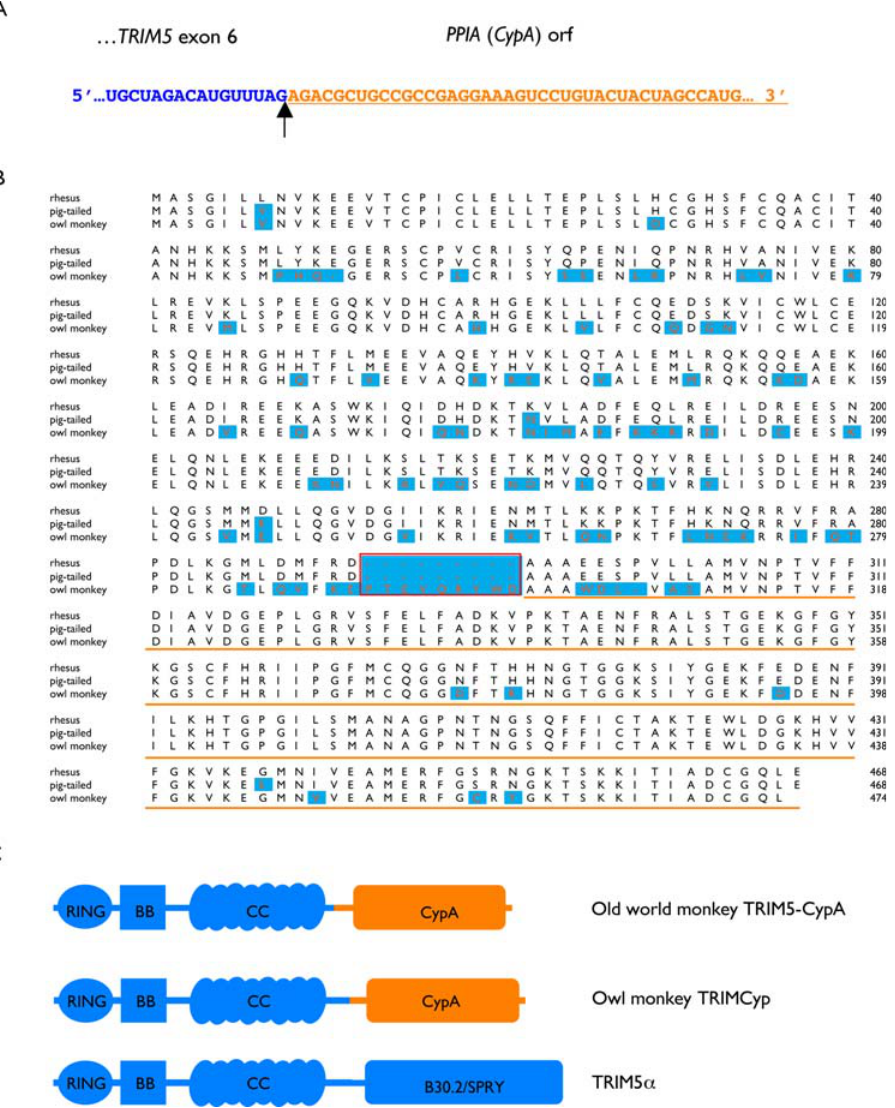
Figure 3. A TRIM5-CypA transcript of macaques is generated by alternative splicing. A. Messenger RNA sequence spanning the junction between the TRIM5 exon-6 and CypA sequences. B. Predicted amino-acid sequence of rhesus TRIM5-CypA aligned with pig-tailed macaque TRIM5- CypA and owl monkey TRIMCyp. Residues that differ from rhesus TRIM5-CypA are highlighted in blue. The region encoded by exon-7 is boxed in red; as the result of alternative splicing, this sequence is present in owl monkey TRIMCyp, but is missing from old world monkey TRIM5-CypA. C. Cartoon depicting predicted protein sequences of the old world monkey TRIM5-CypA protein (top), the owl monkey TRIM-Cyp protein (middle) and wild type primate TRIM5 a